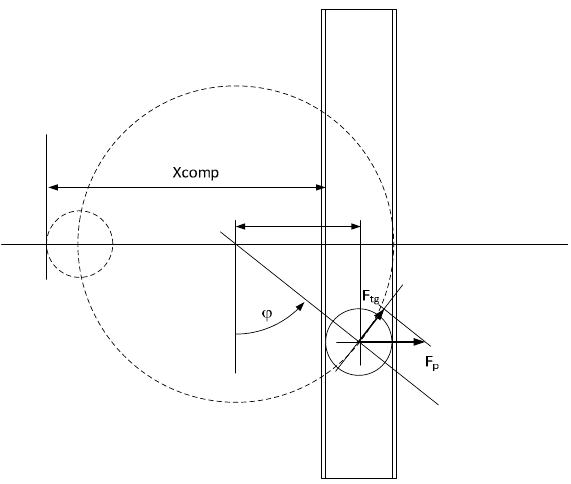
Figure 13. Definition of variables of the Scotch Yoke mechanism.